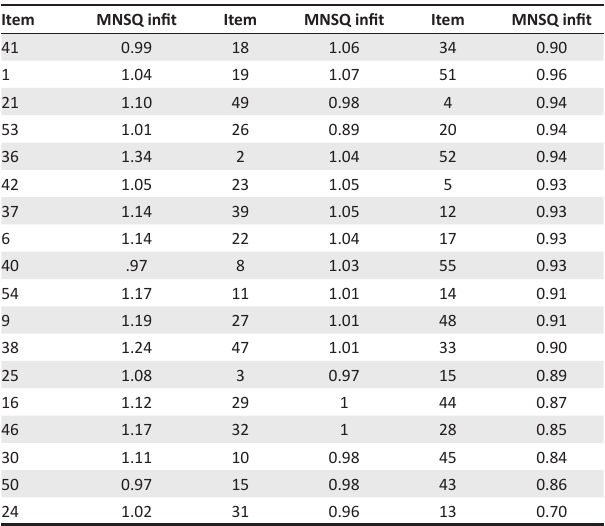
TABLE 2: Fit statistics for the individual items.